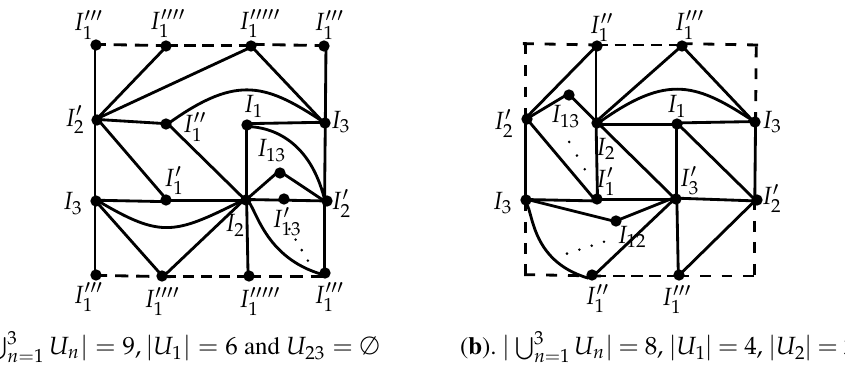
Figure 4. N 2 -embedding of AG ( L )